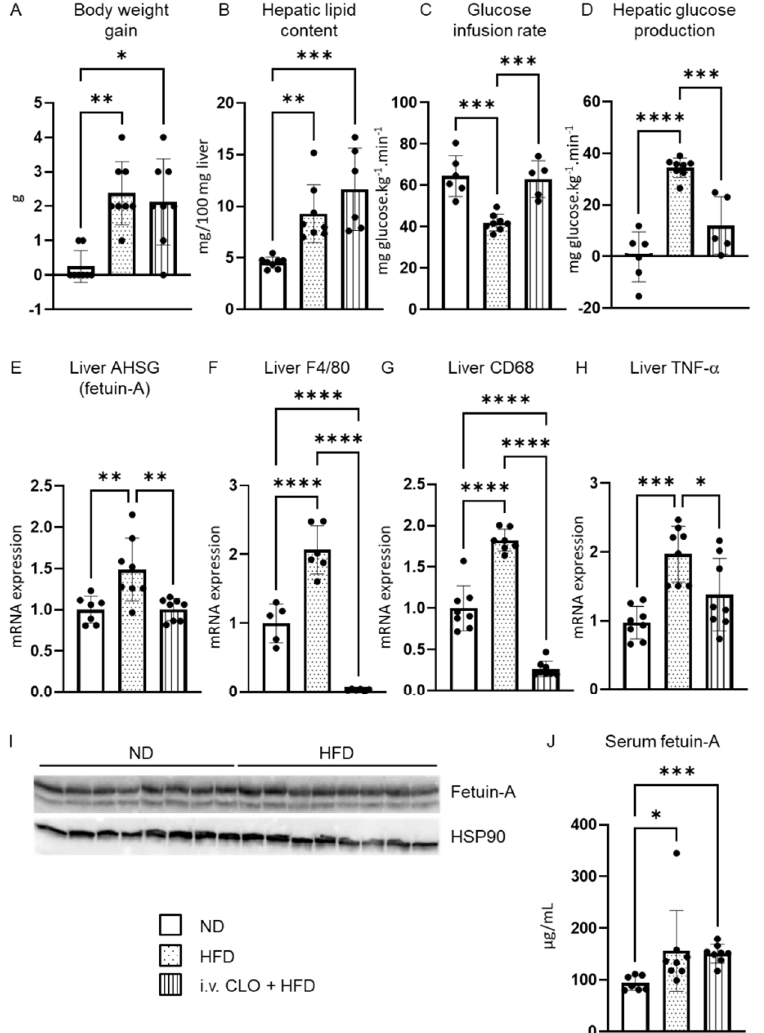
Figure 1. Liver fetuin-A is increased upon short-term high-fat diet and is modulated by liver macrophages. Body weight ( A ), hepatic lipid content ( B ), glucose infusion rate ( C ), and hepatic glucose production (HGP) ( D ) changes in normal diet (ND) mice, 3-day high-fat diet (HFD) mice and 3-day HFD mice with liver macrophage depletion obtained by intravenous (i.v.) clodronate (CLO) injection. Liver mRNA expression of AHSG ( E ), F4/80 ( F ), CD68 ( G ), and TNF- α ( H ). Liver fetuin-A protein ( I ) and serum fetuin-A ( J ) protein expression. Data are expressed as means ± SD. n = 6–8 per group. * p < 0.05, ** p < 0.01, *** p < 0.001, **** p < 0.0001.